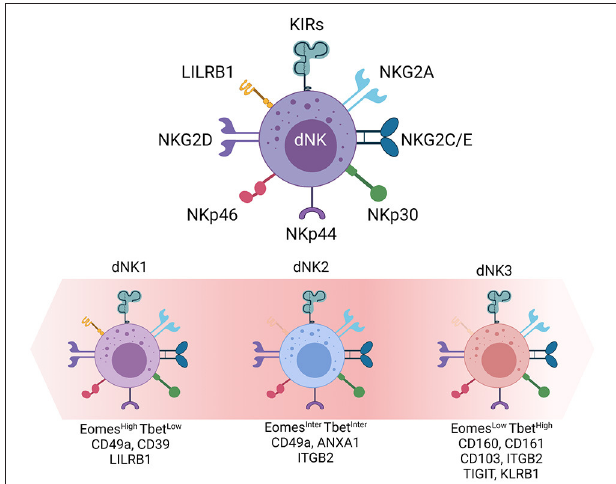
FIGURE 1 | Decidual Natural Killer cells. dNK cells, the main innate immune cell population at the maternal-fetal interface. Inhibitory and activating receptors are presented. Transcription factors (Eomes and Tbet) and cell surface markers (LILRB1, ITGB2, CD160, CD161) defined by single cell RNA sequencing and large scale phenotyping allow the distinction of three dNK cell subsets (dNK1, dNK2, and